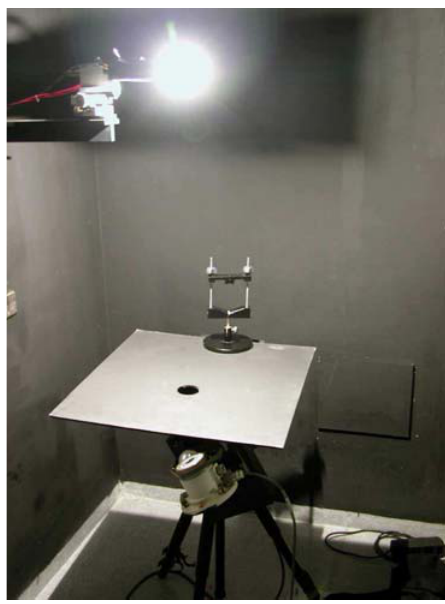
Figure 7. Radiometer under test photography.